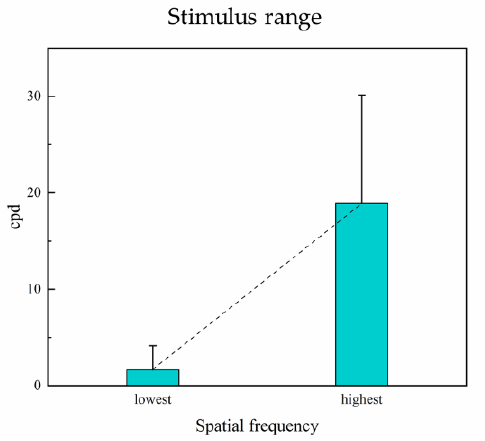
Figure 9. Mean sweep range of lowest and highest spatial frequencies in selected studies. Error bars: SD.